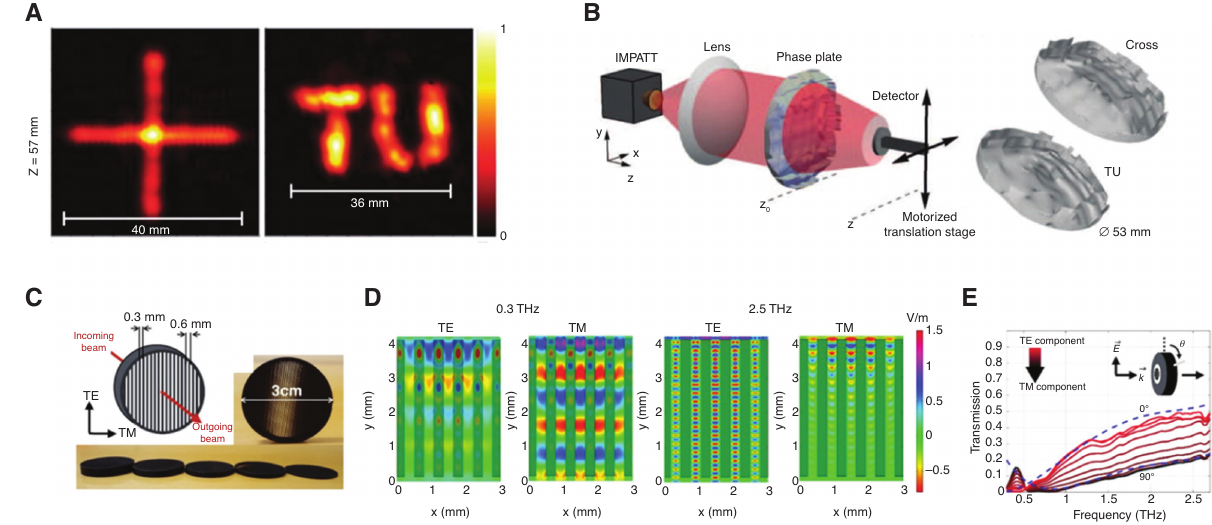
Figure 7: 3D printing for THz applications. (A) Measured intensity profiles of a cross and a university logo of the optical field by an incidence of THz wave. (B) Schematic of the optical setup for intensity profile measurements. Adapted from Ref. [95]. Copyright (2018) AIP publishing. (C) Photograph of a 3D-printed polarizer. (D) Numerical simulation results for the 4 mm propagation length. Light is incident along the y-axis (from the top). The dark green region is a conductive PLA part, while the light green region is air. (E) Transmission amplitude of the THz beam measured after passing through 4 mm polarizer. The dashed lines are numerical predictions for the TE and TM mode. Adapted from Ref. [96]. Copyright (2019) OSA Publishing.